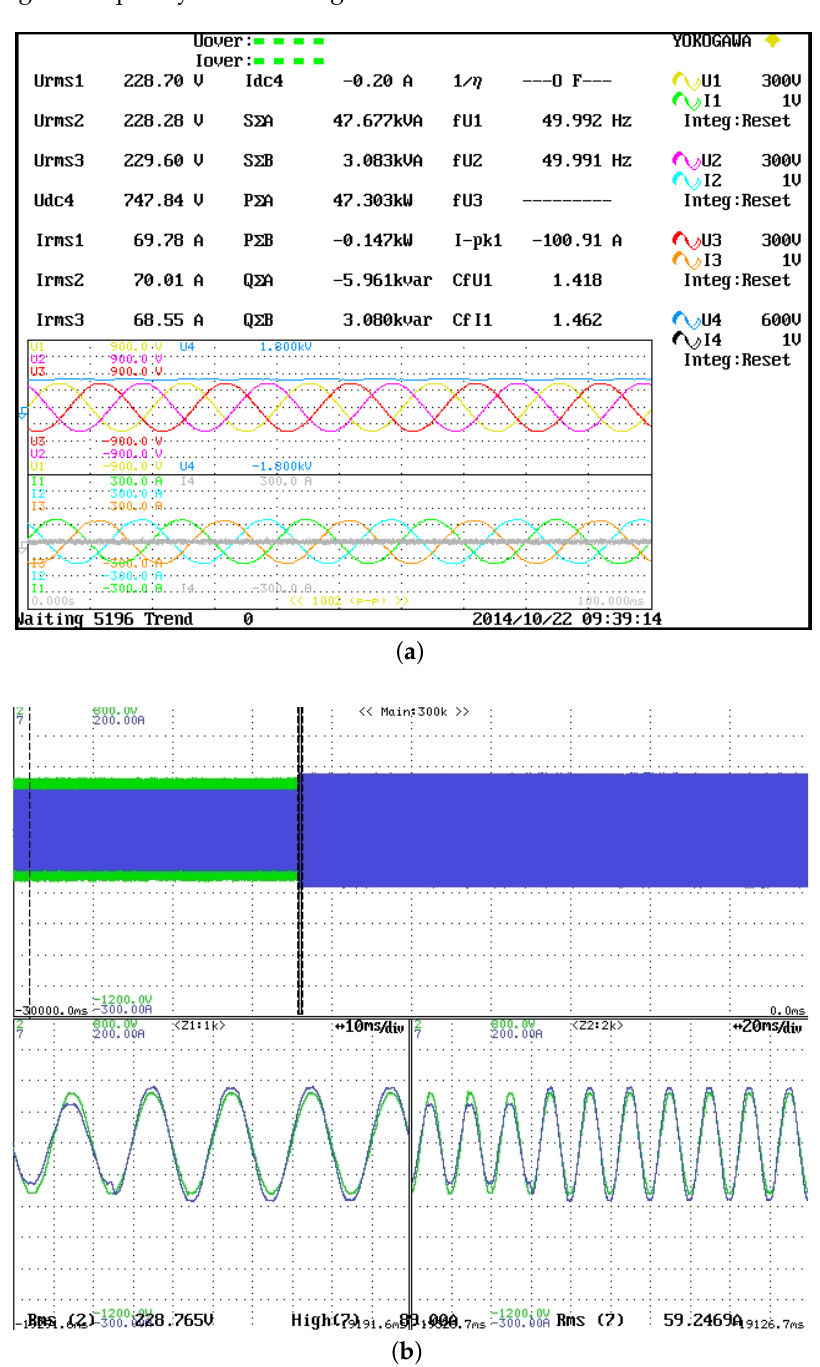
Figure 13. Experimental results of the 100-kW system: ( a ) active power reference at 50 kW, three-phase current and voltage; and ( b ) active power reference jumps from 35 kW to 50 kW, current and voltage in one